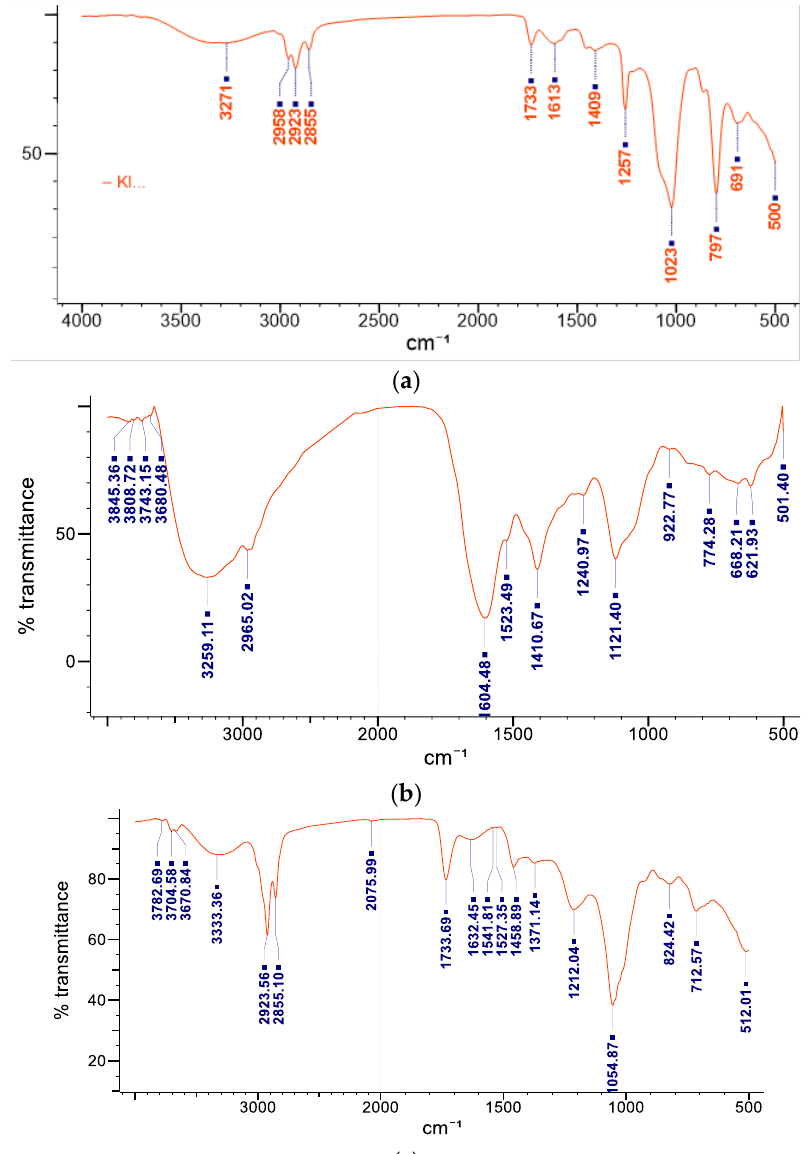
Figure 5. FITR spectra of MoP ( a ), Mopp FTIR spectra ( b ), and phospholipids ( c ).